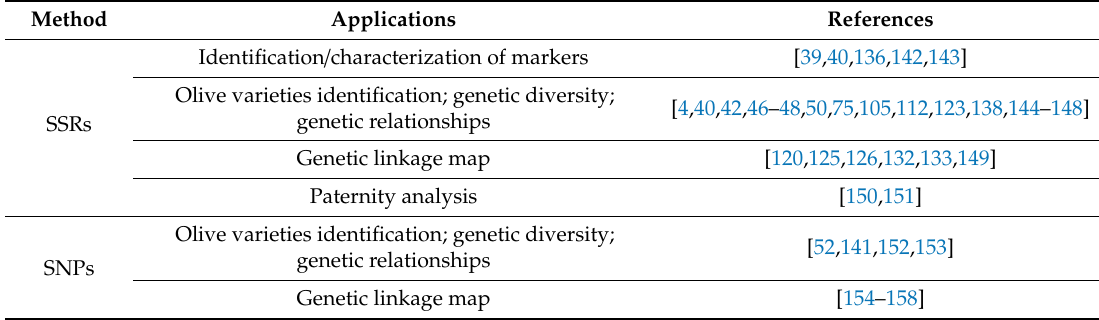
Table 4. Applications of SSRs and SNPs in olive